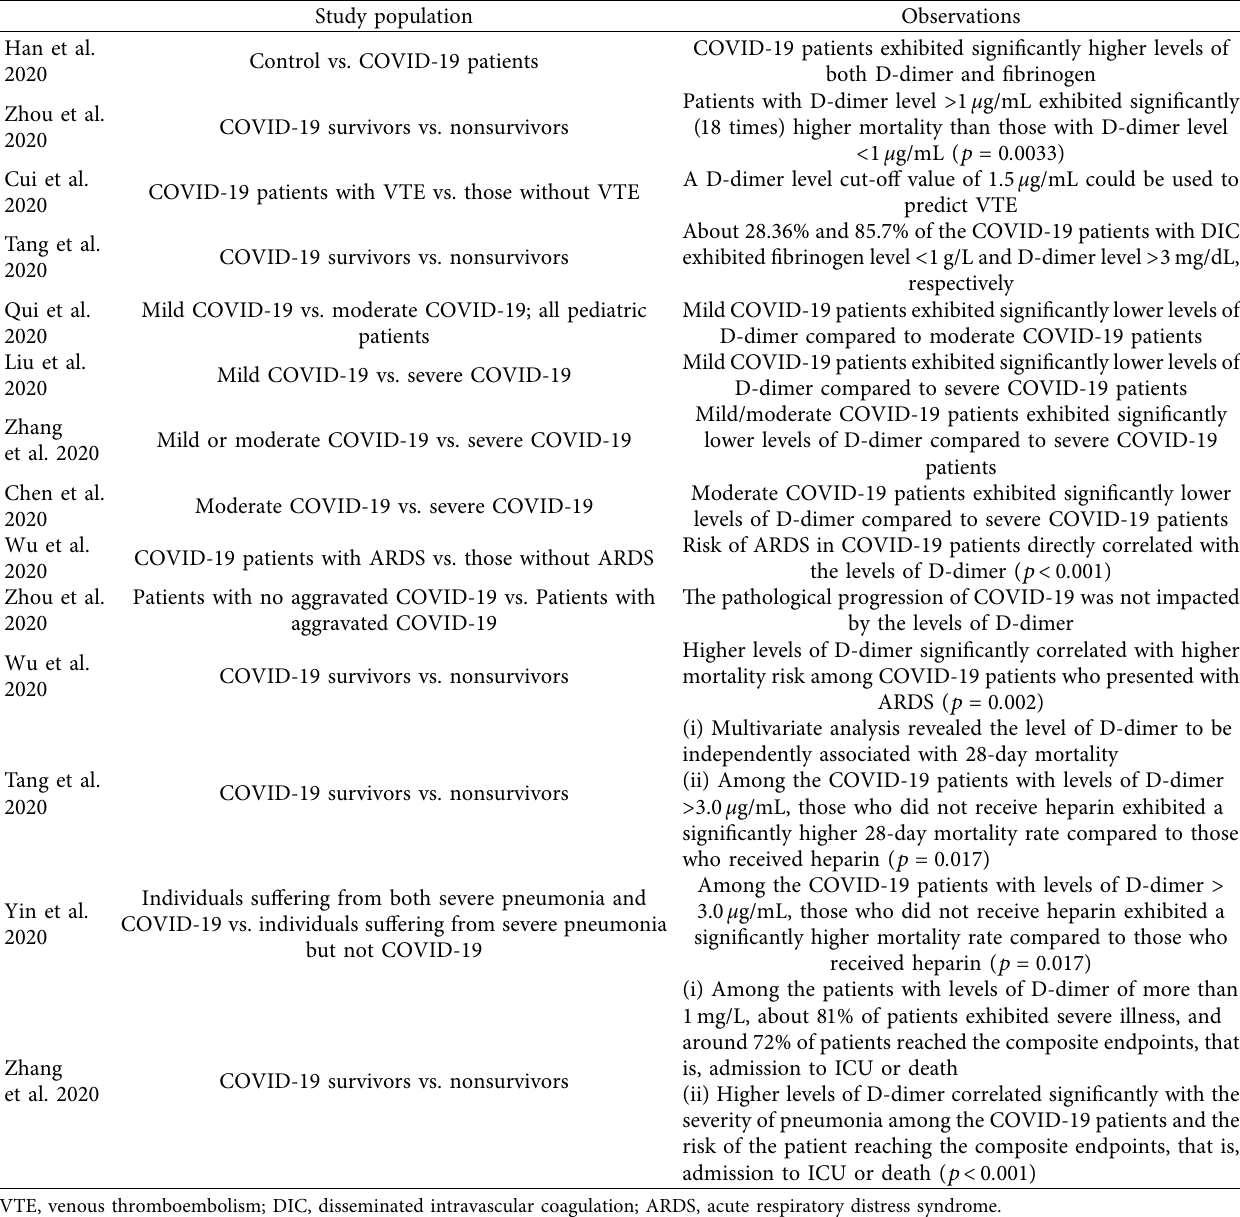
COVID-19 survivors vs.